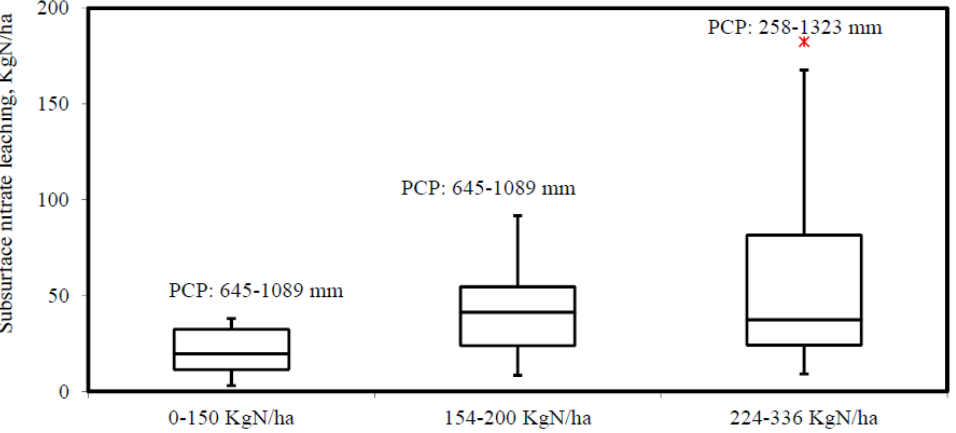
Figure 5. Subsurface nitrogen leaching from silty loam for continuous corn at various ranges of precipitations (six journal articles were used for analysis). PCP: Precipitation.